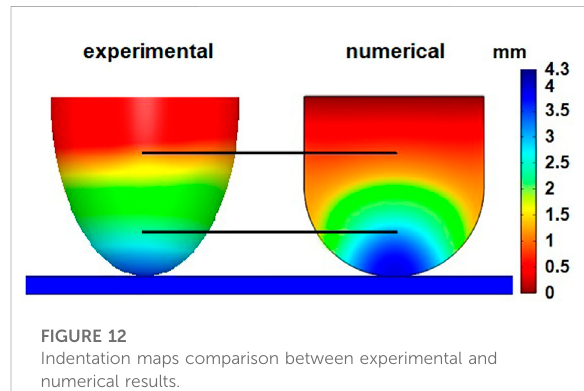
FIGURE 12 Indentation maps comparison between experimental and numerical